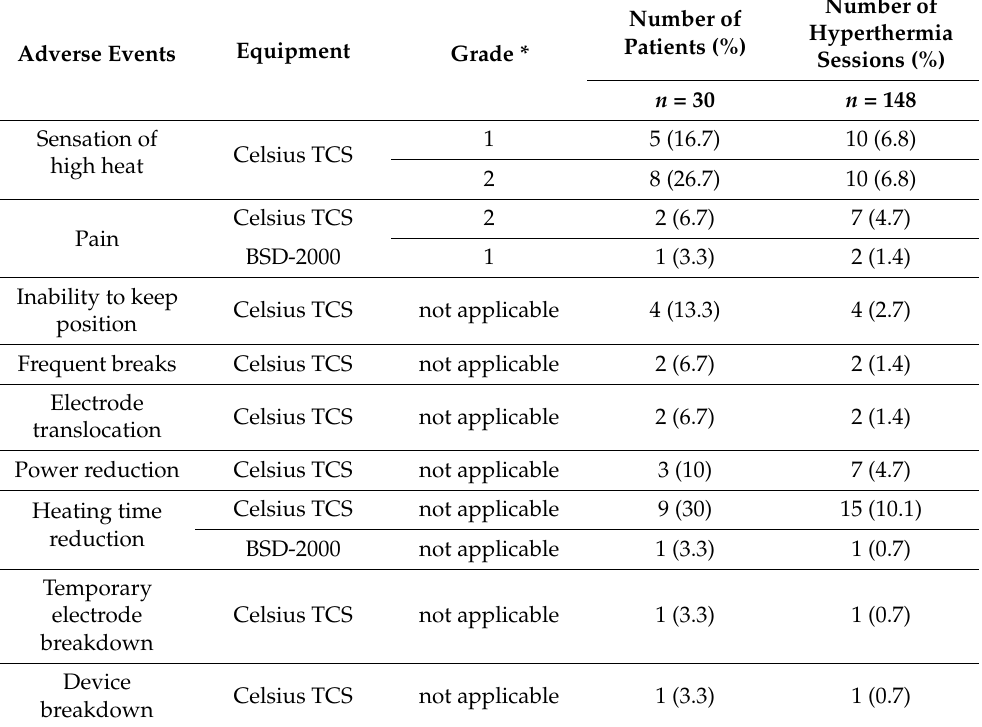
Table 4. The summary of hyperthermia-related adverse